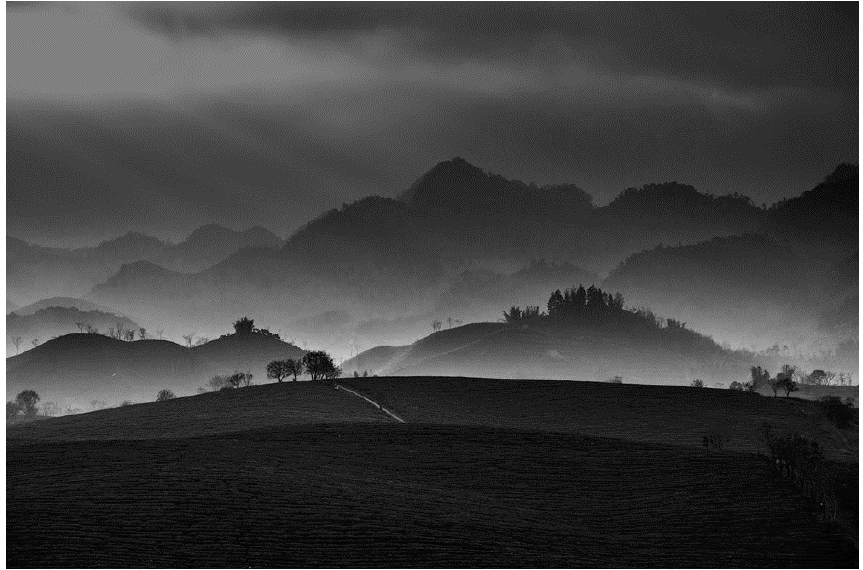
Figure 1. Province of Son La—© Linh Pham on